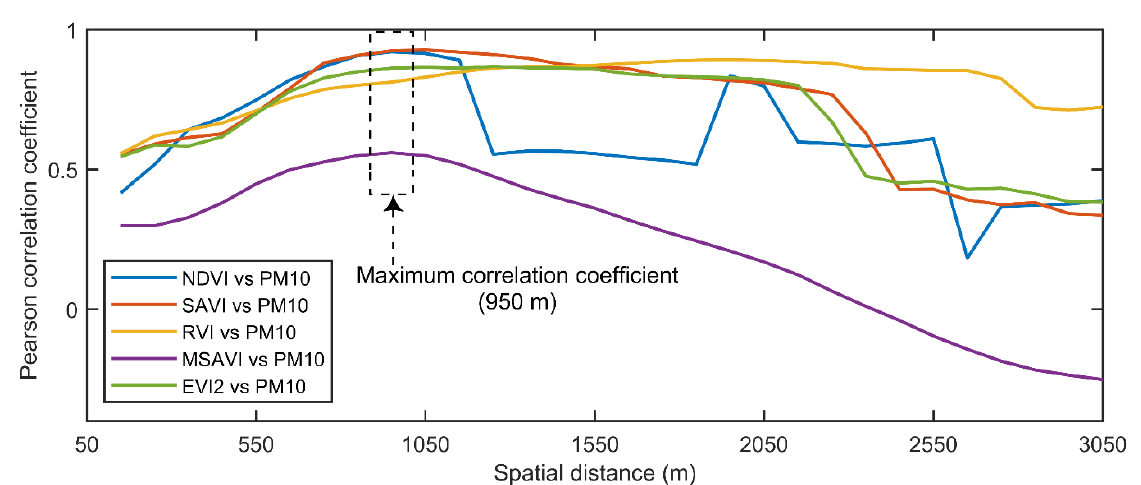
Figure 3. Variations in Pearson correlation coefficients of vegetation indexes versus atmospheric PM10 concentration with different sampling distances. Note that the maximum correlation coefficient occurs at the spatial distance of 950 m.